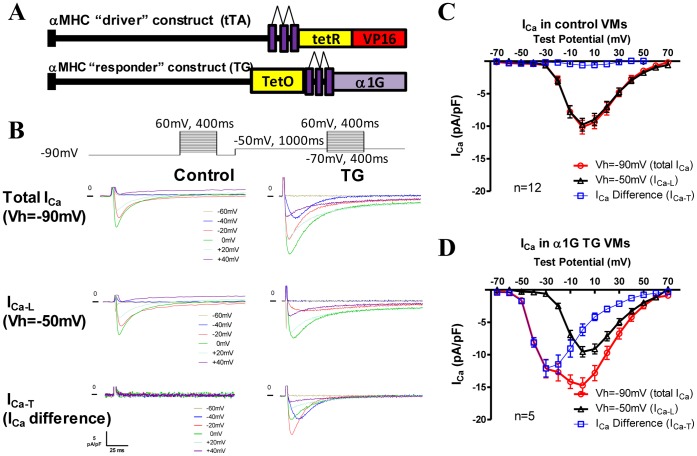
ICa-T(3.1) was expressed only in Cav3.1 TG ventricular myocytes and sensitive to mibefradil but not to dihydropyridines.
A, A schematic of the bitransgenic inducible expression system for cardiac-specific Cav3.1 overexpression. tTA is the tetracycline-controlled transactivator system. tetR, tet-repressor cDNA fused to VP16 (activator domain); tet-O, tet-operon. B, Raw currents of total ICa, ICa-L and ICa-T in a control and a TG VMs. No ICa-T was present in this control cell but robust ICa-T found in the TG VM. C & D, Averaged I–V curves of total ICa, ICa-L and ICa-T in control (n = 12) and TG (n = 13) ventricular myocytes. No ICa-T was detected in control VMs but great ICa-T found in TG VMs.